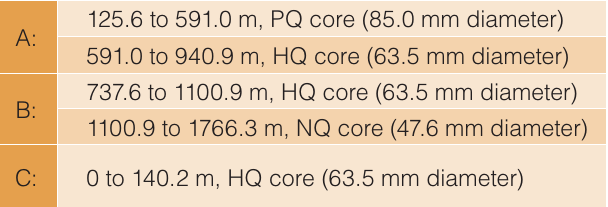
Table 1: Cored sections in Eyreville boreholes.